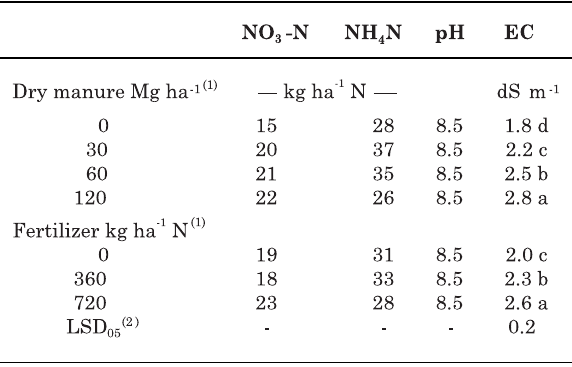
Table 6. Final soil nitrate-nitrogen (NO -N), 3 ammonium-nitrogen (NH -N), pH, and electrical 4 conductivity (EC) measurements conducted at the end of the study after three extraction cycles with annual crops (annual ryegrass-sudan grass- annual